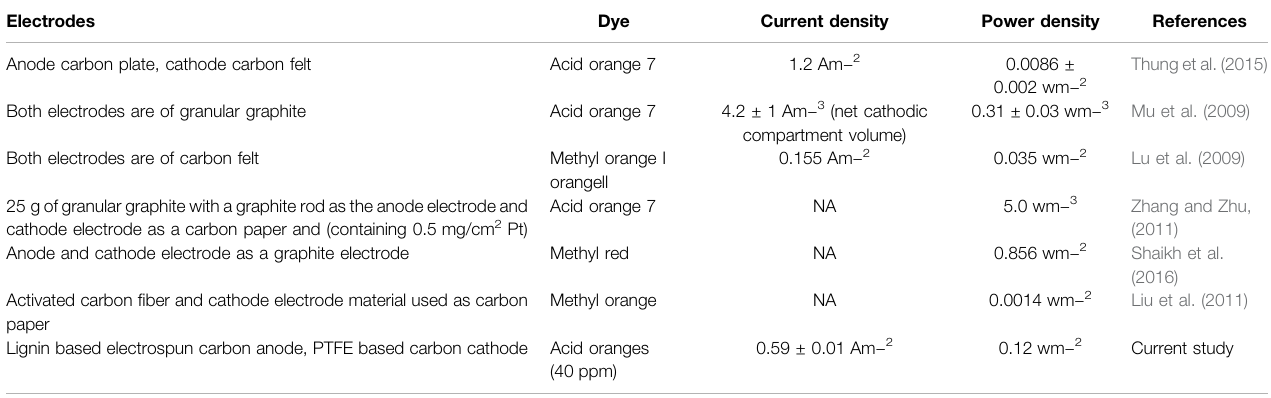
TABLE 1 | Electrochemical performance of MFC during azo dye degradation in various reported studies.